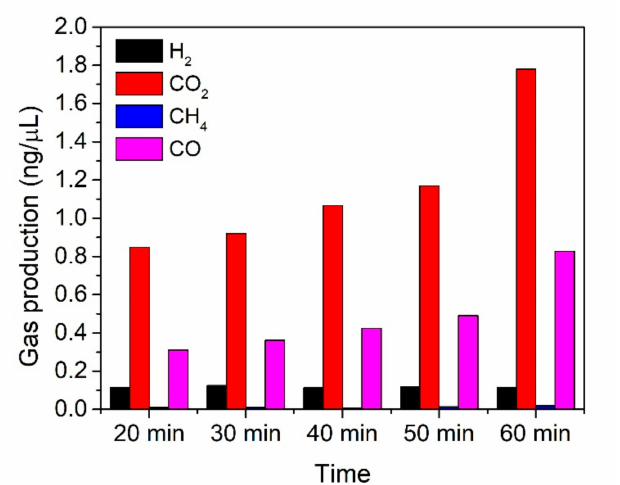
Figure 2. The e ff ect of pyrolysis time in gas production. Temperature: 210 ◦ C, with vacuum pressure in the range of 5–20